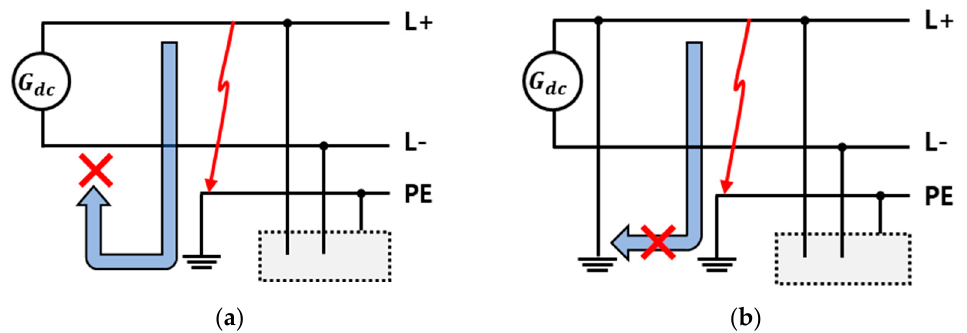
Figure 3. Example of the protection blind spot in a two ‐ wire DC system under a ground fault: ( a ) IT system; ( b ) Positive grounded TT system.